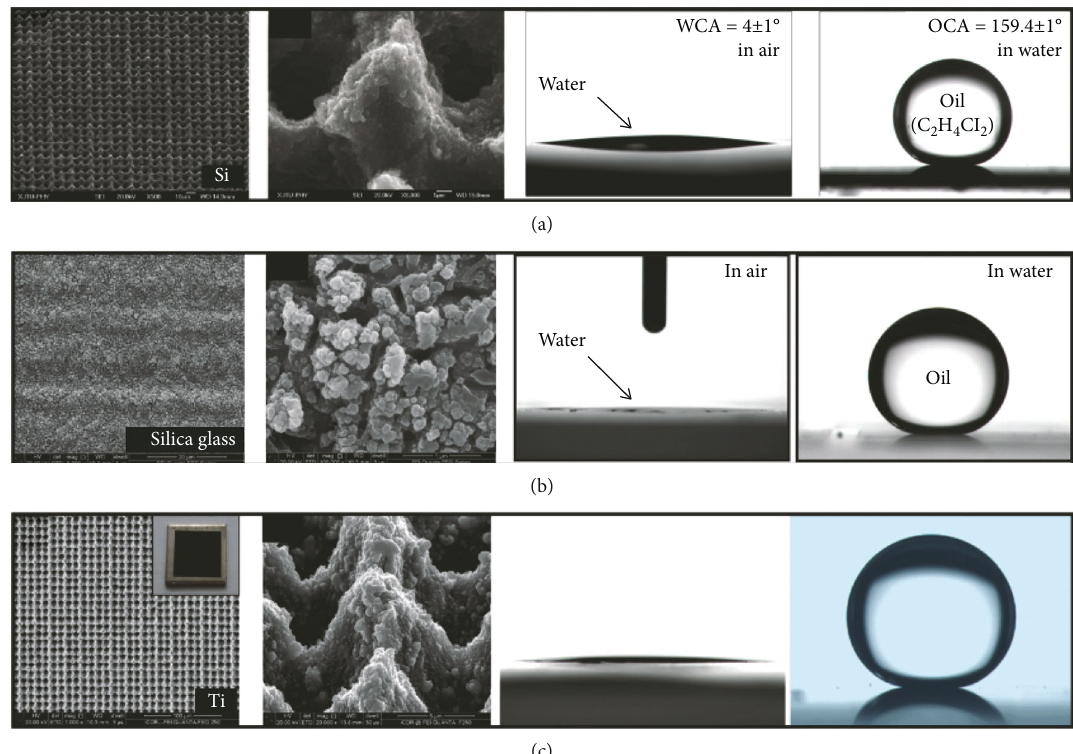
Figure 25: Femtosecond laser preparation of underwater superhydrophobic surfaces of di ff erent materials: (a) silicon [113], (b) quartz glass [114], and (c) titanium